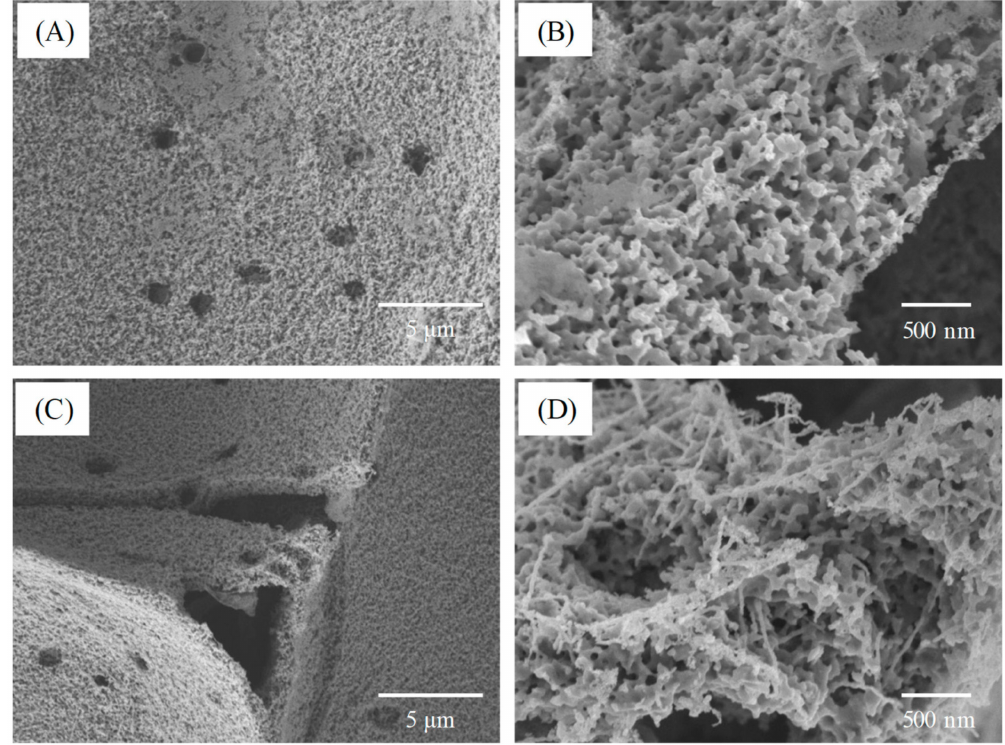
Figure 7. SEM micrographs of sintered BcSiCs prepared using three ( A , B ) and five repeated cycles ( C , D ) of sol–gel